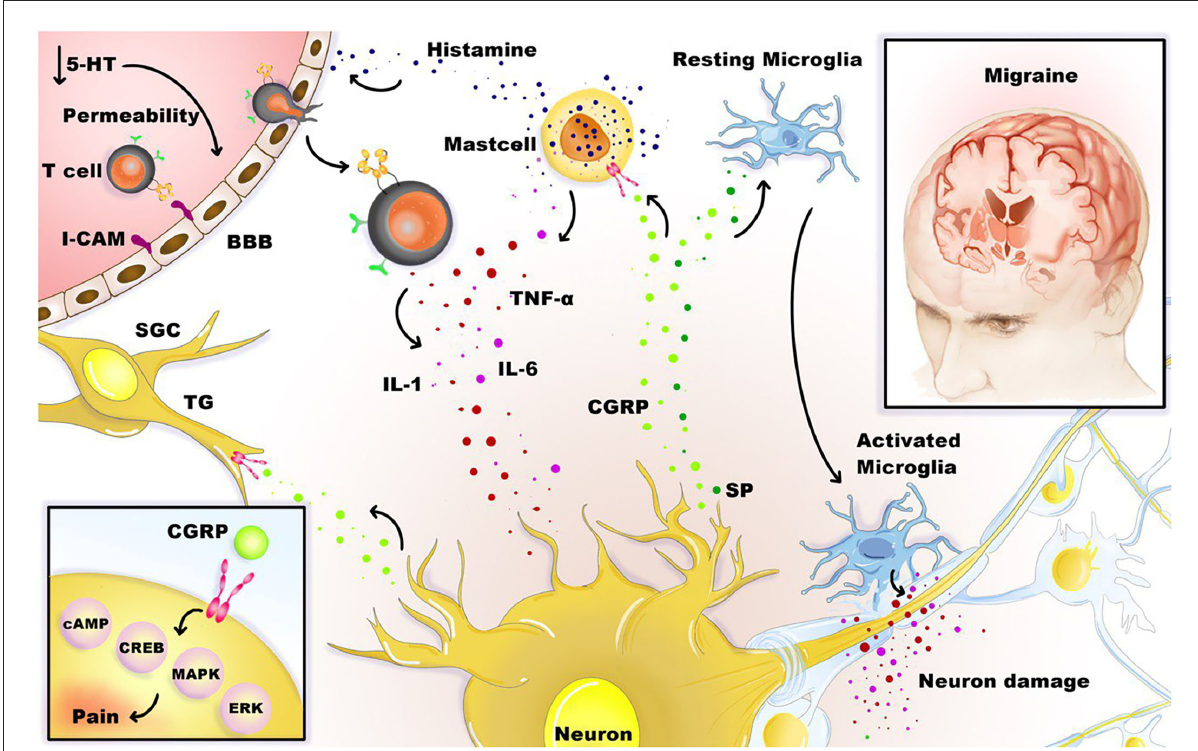
FIGURE1 Neuroinflammation and migraine. Stimulation of the trigeminal neurons causes the release of neuropeptides, including CGRP, substance P (SP), leading to mast cell degranulation, leukocyte infiltration, glial cell activation, and increased production of inflammatory TNF- α , IL-1, and IL-6 cytokines. Besides, satellite glial cells (SGCs) and trigeminal ganglions (TG) express receptors for CGRP, and CGRP can stimulate intracellular signaling molecules that are relevant to pain, such as cAMP, CREB, MAPK, and ERK. Under the influence of inflammation, activated microglia, T cells, and mast cells can boost the inflammation loop and production of cytotoxic mediators in the